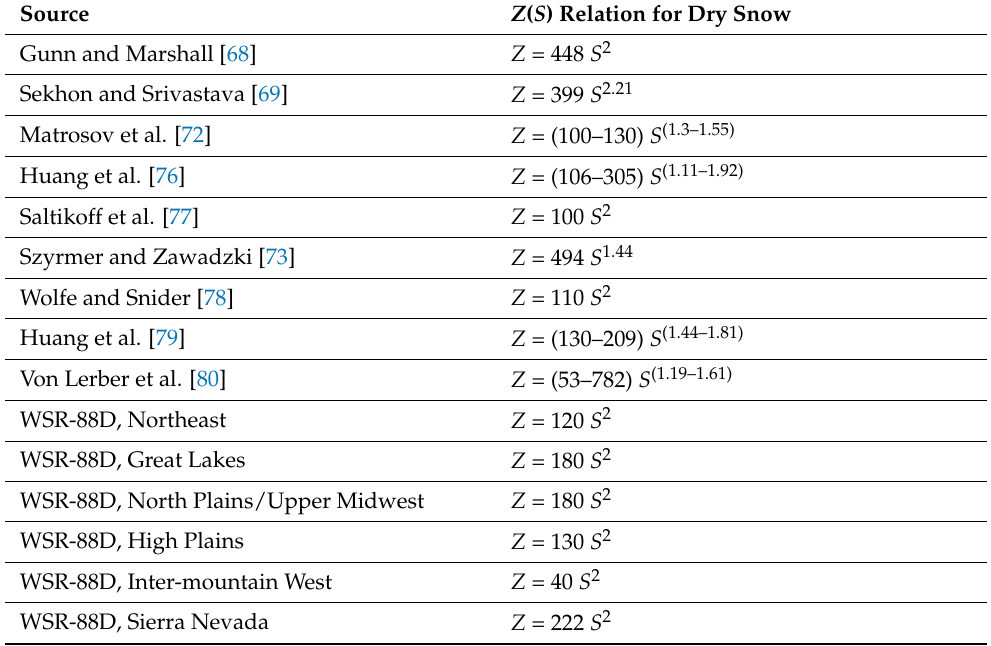
Table 1. Summary of Z ( S ) relations for dry snow listed in the literature and utilized by the WSR-88D network in the United